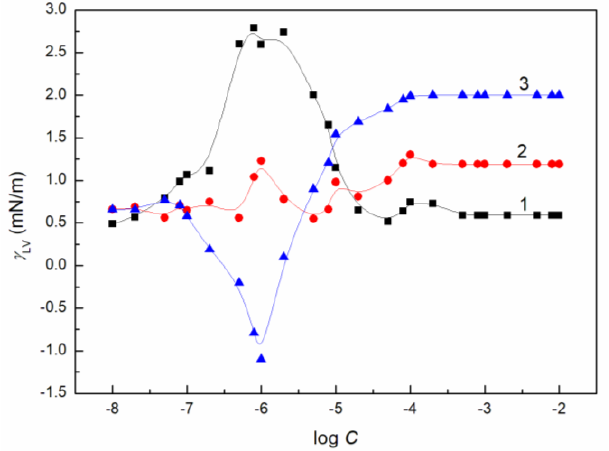
Figure 5. A plot of the difference between the surface tension ( γ LV ) of aqueous solutions of AuO + ELP and ELP (curve 1), AuO + RH40 and RH40 (curve 2) and AuO + ELP + RH40 ( 𝛼 = 0.8) and ELP + RH40 ( 𝛼 = 0.8) (curve 3) vs. the logarithm of ELP, RH40 and ELP + RH40 concentration, respec- tively. Table 1. The values of the 𝑦 , 𝐴 1 , 𝐴 2 , t 1 , t 2 (Equation (5)), Γ 𝑚𝑎𝑥 (mol/m 2 , Equation (6)), 𝑎 (Equa- tion (6)) and 𝐺 𝑎𝑑𝑠0 (kJ/mol, Equation (24)) for AuO, ELP and RH40 as well as AuO + ELP, AuO + RH40 and AuO + ELP + RH40 mixtures.